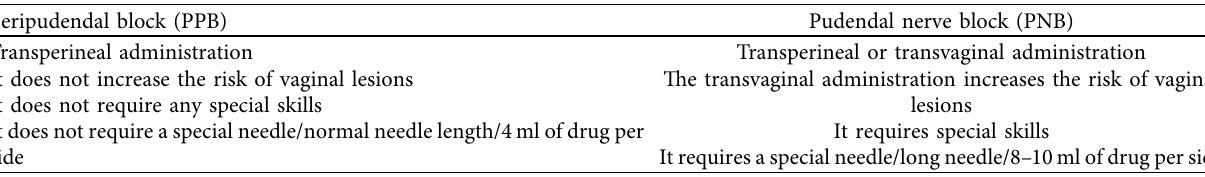
Table 3: Comparison of the peripudendal block with the traditional pudendal nerve block. Peripudendal block (PPB)